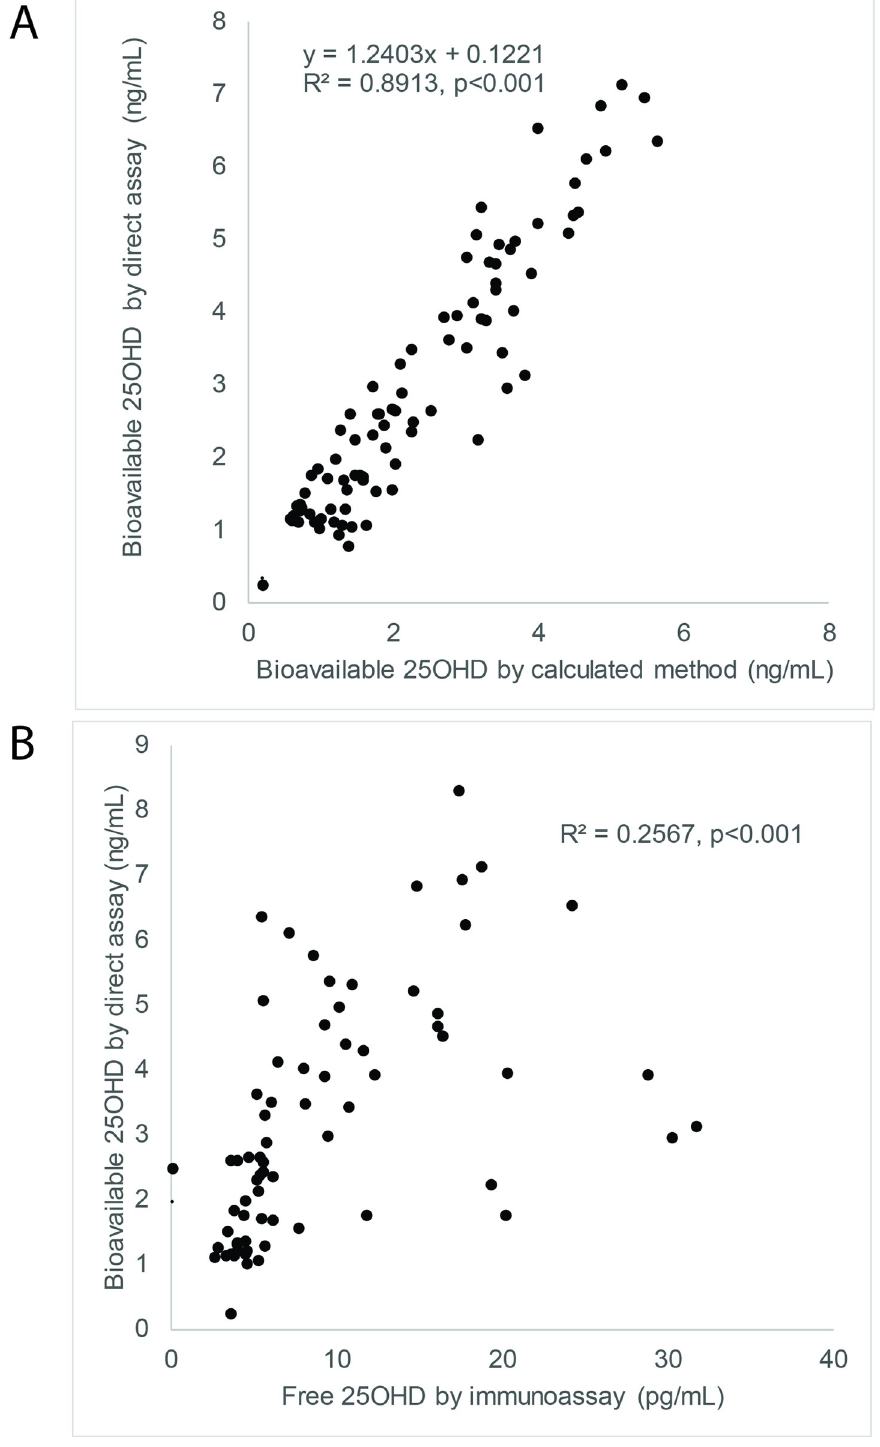
Fig 4. Linearity of relationships between calculated and measured concentrations of serum bioavailable 25OHD. (A) Linear relationships between bioavailable 25OHD measured by direct binding assay and calculated bioavailable 25OHD. (B) Linear relationships between bioavailable 25OHD measured by direct binding assay and free 25OHD measured by immunoassay.